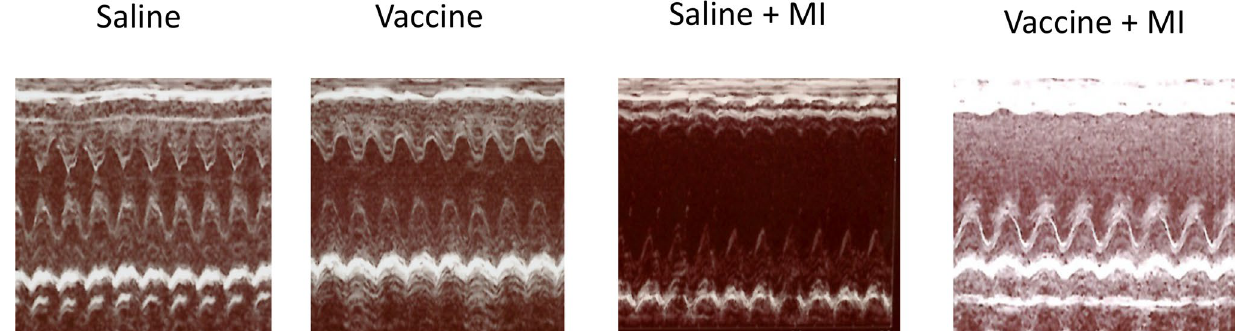
Figure 2. The sEH vaccine treatment improved cardiac function in MI model rats. Representative images of cardiac ultrasonography. Cardiac ultrasonography was carried out before MI induction (on the day of surgery) and after MI induction (7 days later).